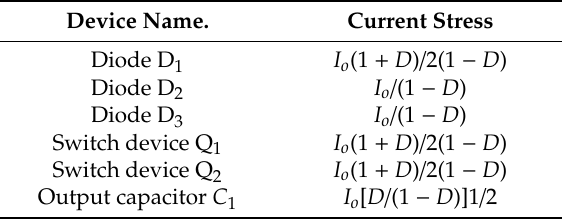
Table 1. Current stress of each component. Device